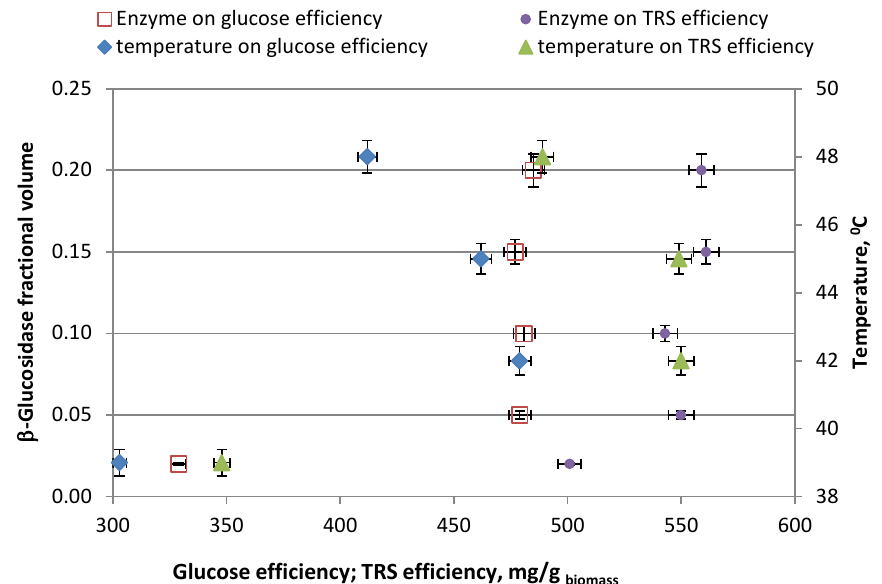
Figure 3. Glucose and total reducing sugar (TRS) e ffi ciency depending on enzymatic hydrolysis parameters.